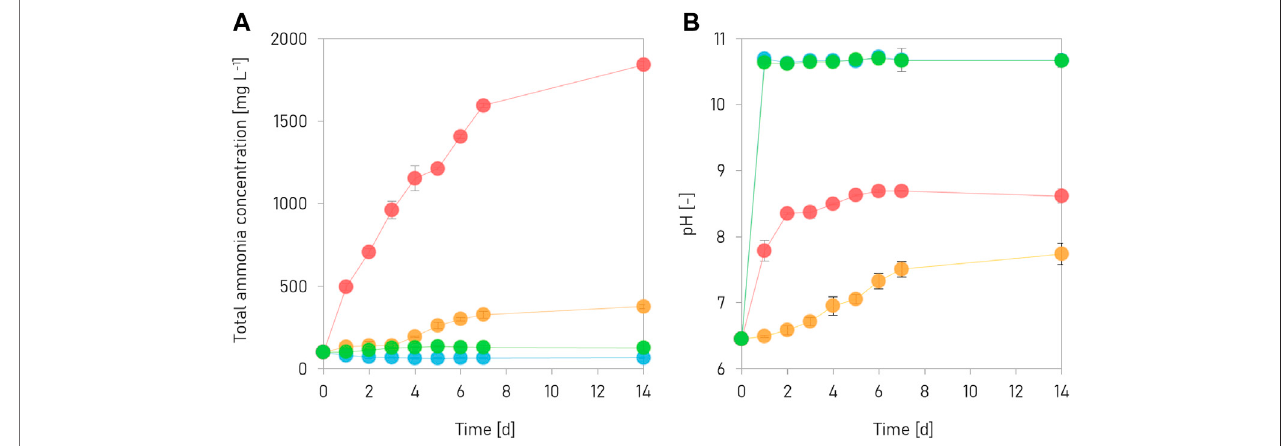
FIGURE 1 | The (A) concentration of total ammonia nitrogen (TAN) and the (B) pH is shown over time (days) for fresh human urine, with (red) and without (orange) contaminationbyjackbeanureaseandforfreshhumanurinealkalisedusingMg(OH) 2 ,with(green)andwithout(blue)contaminationbyjackbeanurease.Datapointsare average values of three replicates and error bars show the standard